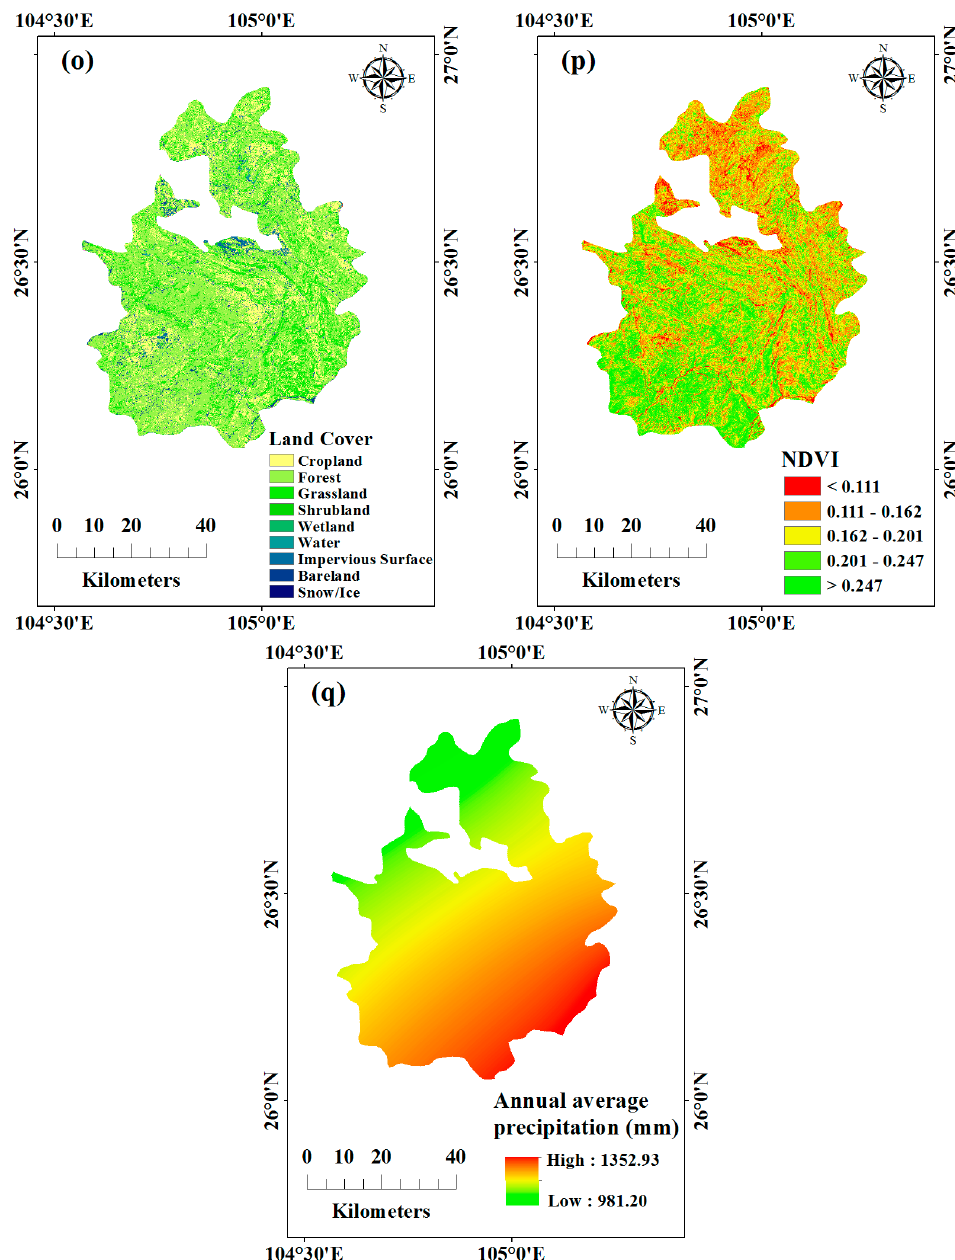
Figure 2. Thematic maps of conditioning factors. ( a ) Elevation, ( b ) Slope, ( c ) Aspect, ( d ) Plan curvature, ( e ) Profile curvature, ( f ) Lithology, ( g ) Geological age, ( h ) Distance to faults, ( i ) Distance to roads, ( j ) Distance to rivers, ( k ) Stream power index (SPI), ( l ) Sediment transport index (STI), ( m ) Topographic relief index (TRI), ( n ) Topographic wetness index (TWI), ( o ) Land cover, ( p ) Normalized difference vegetation index (NDVI), ( q ) Annual average precipitation (AAP).